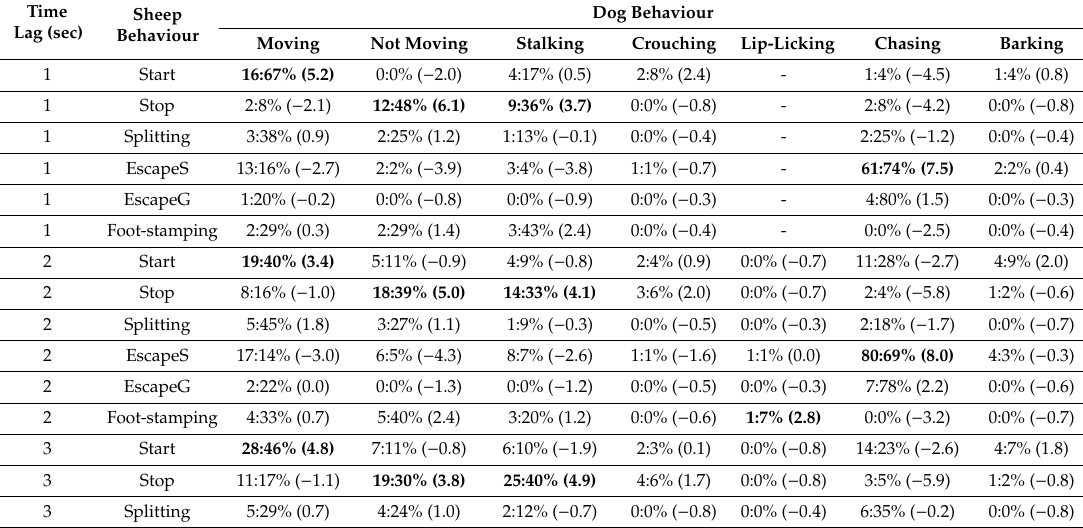
Each paired interaction details three results—Observed frequency: Conditional probability in percentage and adjusted residual in parentheses. Significant positive linkage between behaviours are highlighted in bold. Escape S: Escape single; Escape G: escape group. Table A5. Summary of observed frequencies, conditional probabilities, and adjusted residuals of dog behaviour in response to sheep behaviour across the three time-based lags (one, two and three